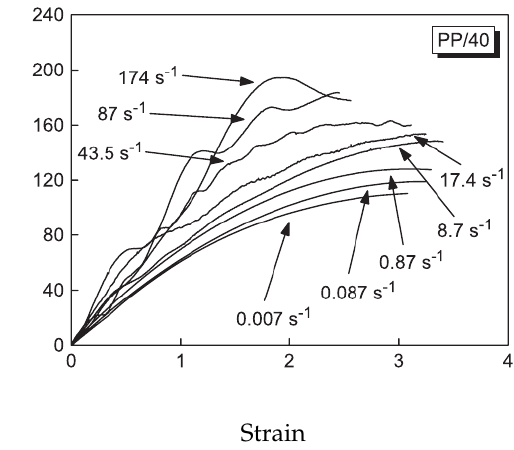
Figure 1. Stress-strain diagrams for PP with 40% glass fibers at different strain rates [15].